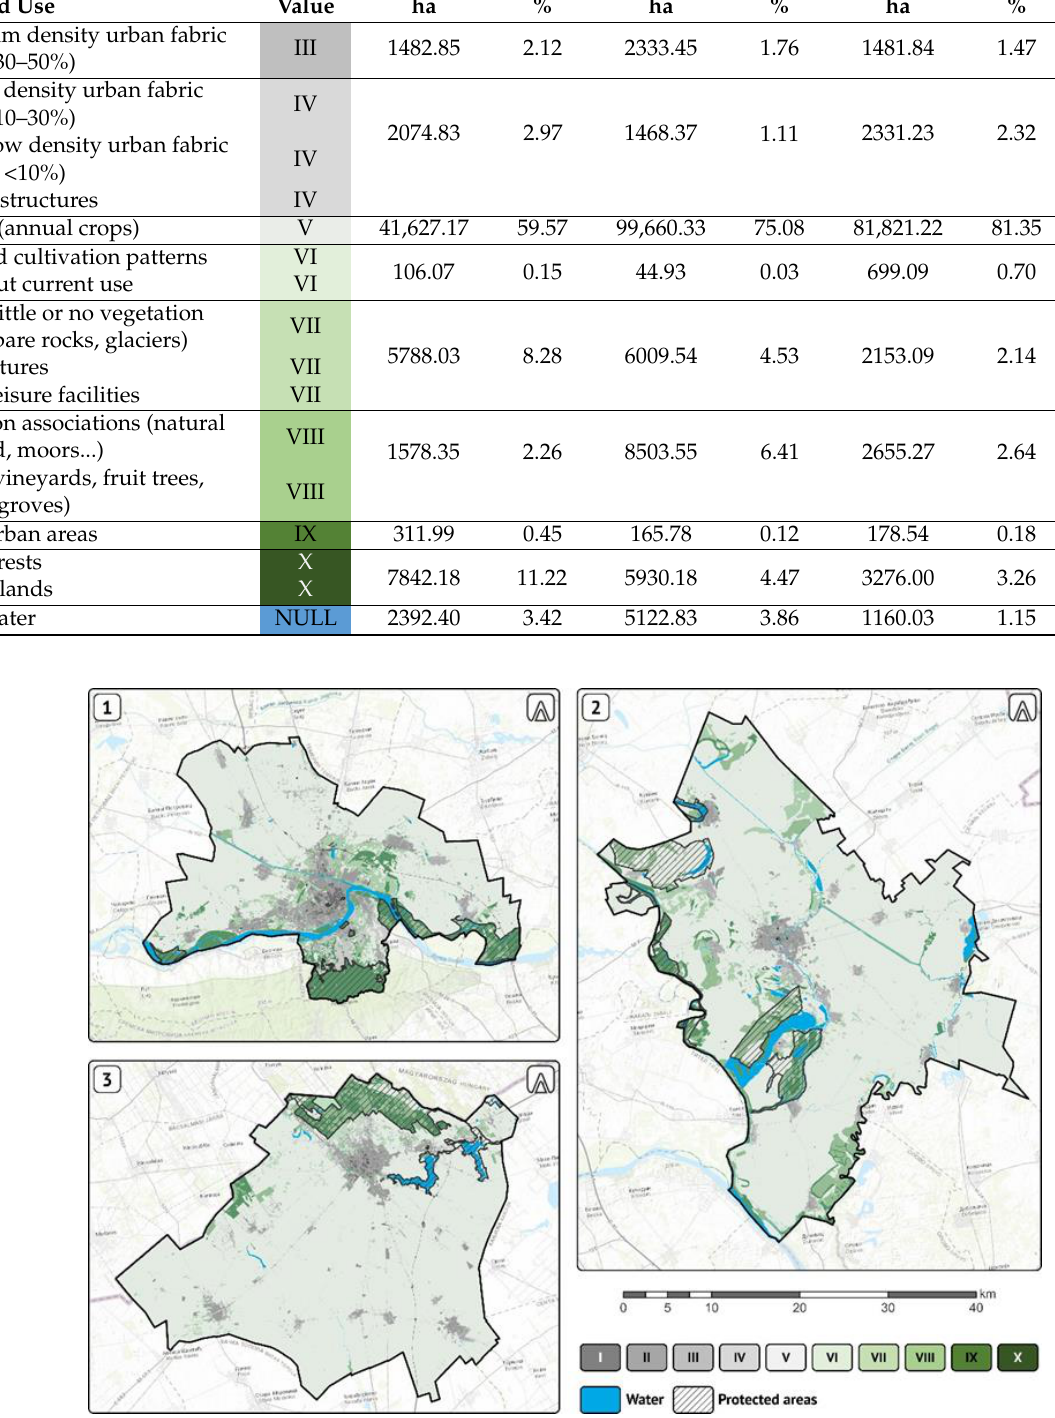
Figure 3. The Grey-Green Continuum applied in the territories of ( 1 ) Municipality of Novi Sad; ( 2 ) Municipality of Zrenjanin; ( 3 ) Municipality of Subotica. A detailed legend is presented in Figure 2b (GGC). Table 2. The classification of landscape element classes according to the Grey-Green Continuum concept.